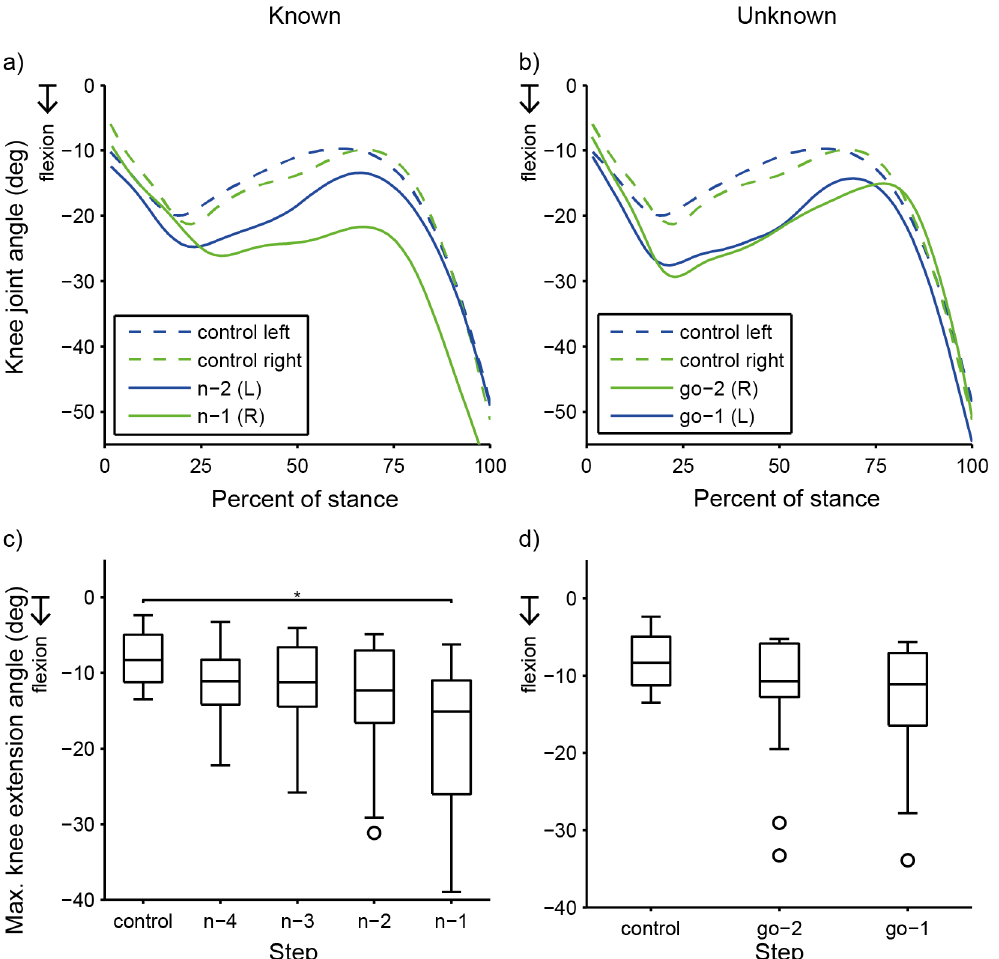
Fig 6. Knee Joint Angle. Example knee joint angle data for one subject comparing a Straight trial vs. a) a Known right trial and b) an Unknown trial. c, d) Each box plot is collapsed across limb side to show main effect of step on peak stance phase knee extension angle. Each box represents 14 subjects ’ data. c) Known. The knee was significantly more flexed at the n-1 step compared to the control step. d) Unknown. There was a significant effect of step on peak knee extension angle, but pairwise comparisons vs. the control step were not significant. ( * )Step is significantly different (p < 0.05) from